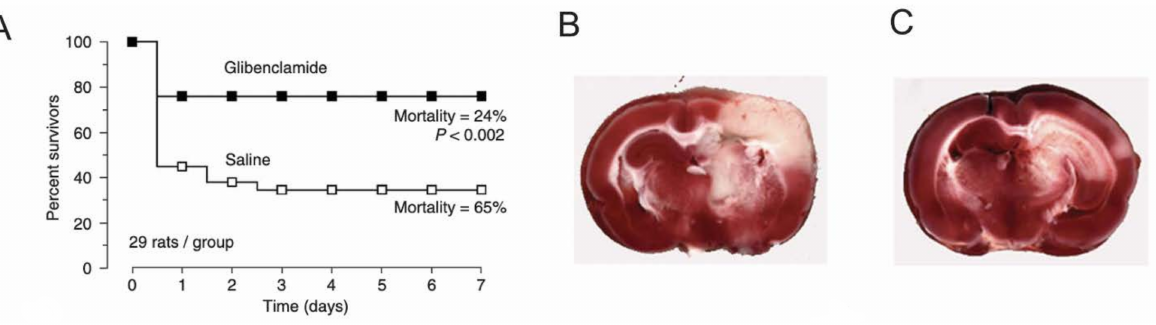
Figure 4. ( A ) Graph showing percent survival of rats over 7 days after middle cerebral artery occlusion (MCAO, malignant cerebral edema model) when treated by saline (open squares) vs. glibenclamide (filled black squares). At 7 days, mortality was significantly different in the glibenclamide group (24%) vs. vehicle group (65%, p < 0.002). Representative TTC-stained coronal sections 2 days after MCAO (thromboembolic model) in a rat treated with saline ( B ) vs. glibenclamide ( C ) showing cortical sparing in the latter. Adapted with permission from Ref.